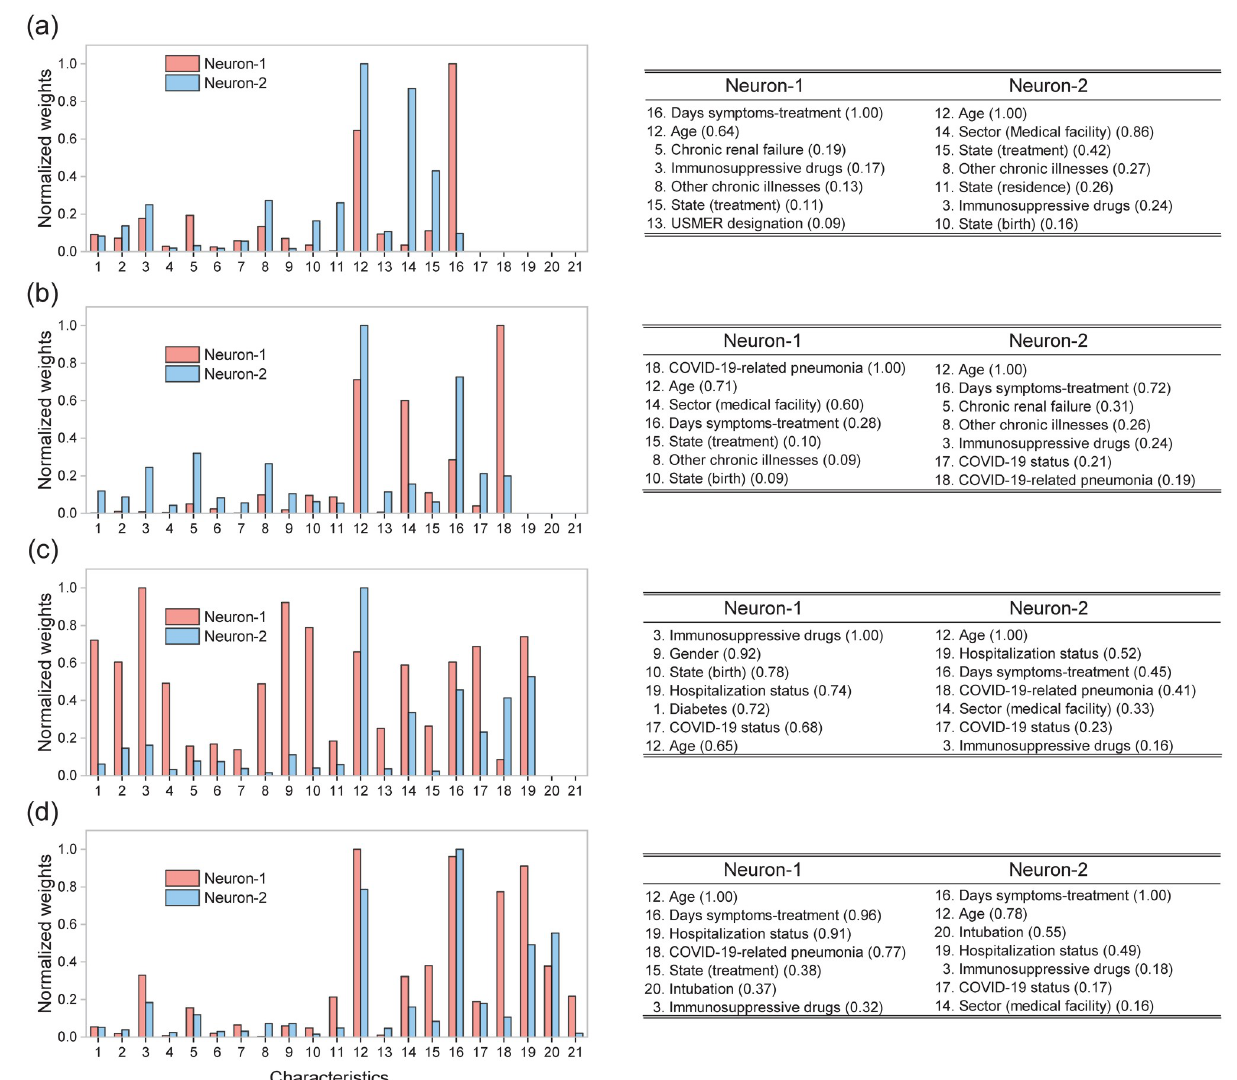
Fig 8. Left: Normalized absolute values of the synaptic weights for the two sigmoid neurons in the hidden layer for each clinical stage: (a) Stage 1, (b) Stage 2, (c) Stage 3, and (d) Stage 4. Right: tables describing the seven dominant characteristics for each of the two neurons the hidden layer, ranked by the absolute value of the synaptic weight (value shown within